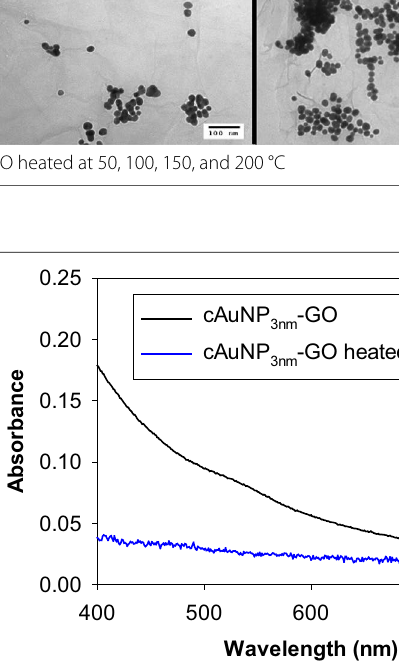
Fig. 6 UV‑vis spectra of cAuNP 3nm ‑GO before and after heat treatment at 50